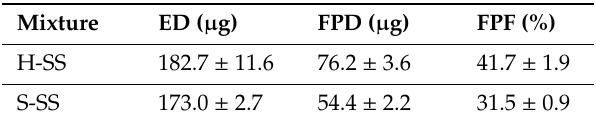
Figure 4. Salbutamol sulphate deposition profile from binary mixture with α -lactose monohydrate (M-SS), stable anhydrous α -lactose (S-SS), and hygroscopic anhydrous α -lactose (H-SS) with an next generation impactor (NGI) apparatus. The bars represent the standard deviation ( n = 5). Table 4. In Vitro deposition tests—ED, FPD, and FPF of salbutamol sulphate (SS) from binary mixtures containing di ff erent polymorphs of lactose as carriers: hygroscopic anhydrous α -lactose, H; stable anhydrous α -lactose, S.